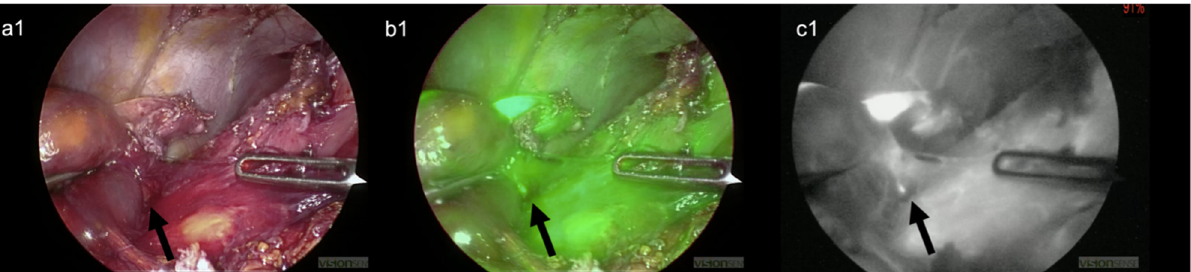
Figure 2. Lysis of the dense adhesions between the liver, the stomach, and the right crus of the diaphragm. EleVisionTM IR platform (Medtronic Ltd., Hertfordshire, England) allowed for the clear visualization of a vessel hidden in the tight scar tissue between liver and stomach (arrow), and this helped in the laparoscopic adhesiolysis. ( a1 ) Visible-light image ( b1 ) green filter image ( c1 ) near-infrared (NIR) image.